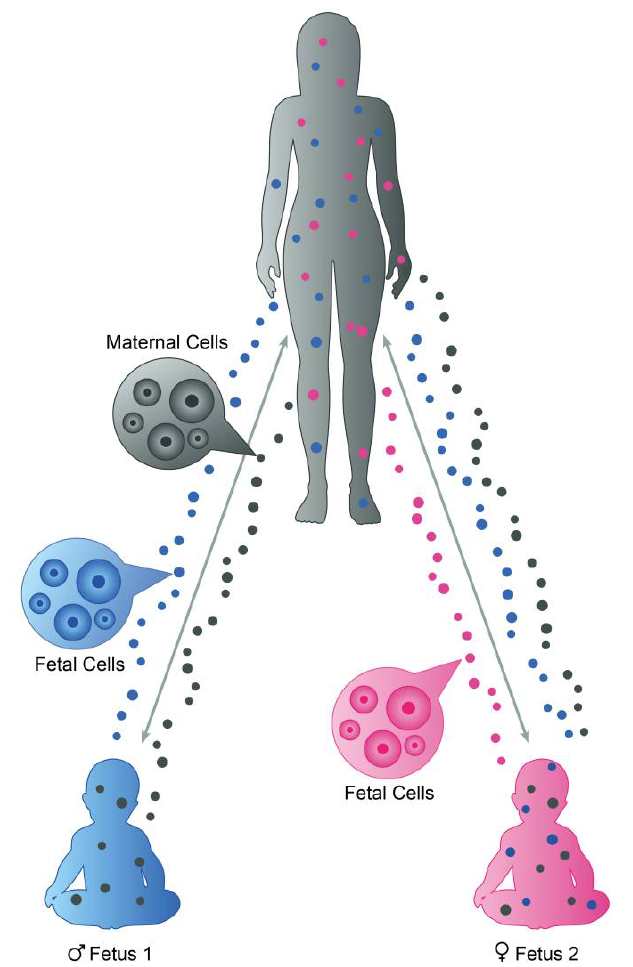
Figure 1. The mother of proband acquires fetal cells during her first pregnancy (fetus 1) which cells are transferred to fetus 2 in a subsequent pregnancy. The proband with RPL is illustrated as fetus 2 in this figure; she harbors microchimeric cells from both her mother and her older brother.